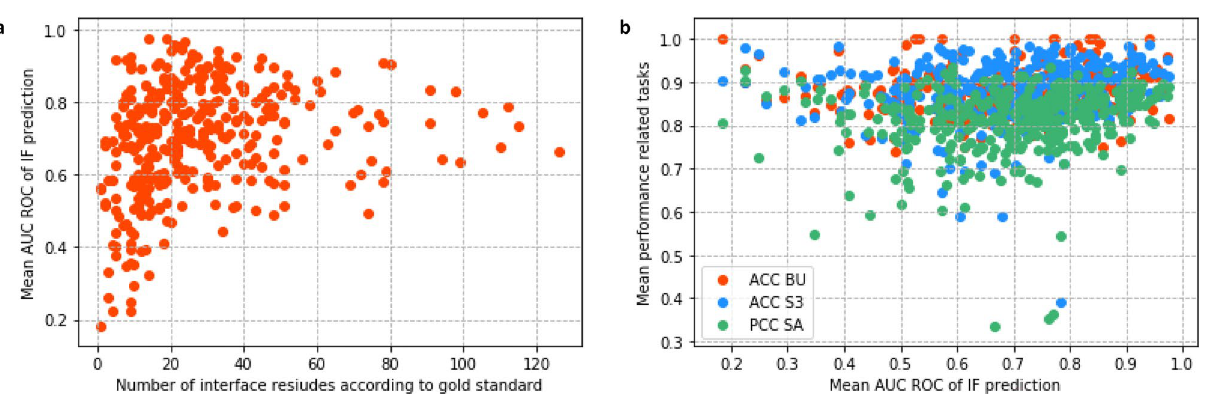
Figure 6. Error analysis on the individual proteins in the test set after training the IFBUS3SA model on the PPI_extendedSFD dataset. ( a ) The mean AUC ROC of the interface prediction is plotted against the number of interface residues per protein. Low AUC ROC scores (< 0.4) are only observed when the interface region of the protein is small (< 20 residues). ( b ) The mean accuracy of the predicted structural features (BU, S3 and SA), and the mean Pearson correlation coefficient of the absolute solvent accessibility are plotted against the mean AUC ROC score of the PPI interface prediction per protein. Linear regression was performed resulting in an R 2 of 0.010 (BU), 0.016 (S3) and 0.031